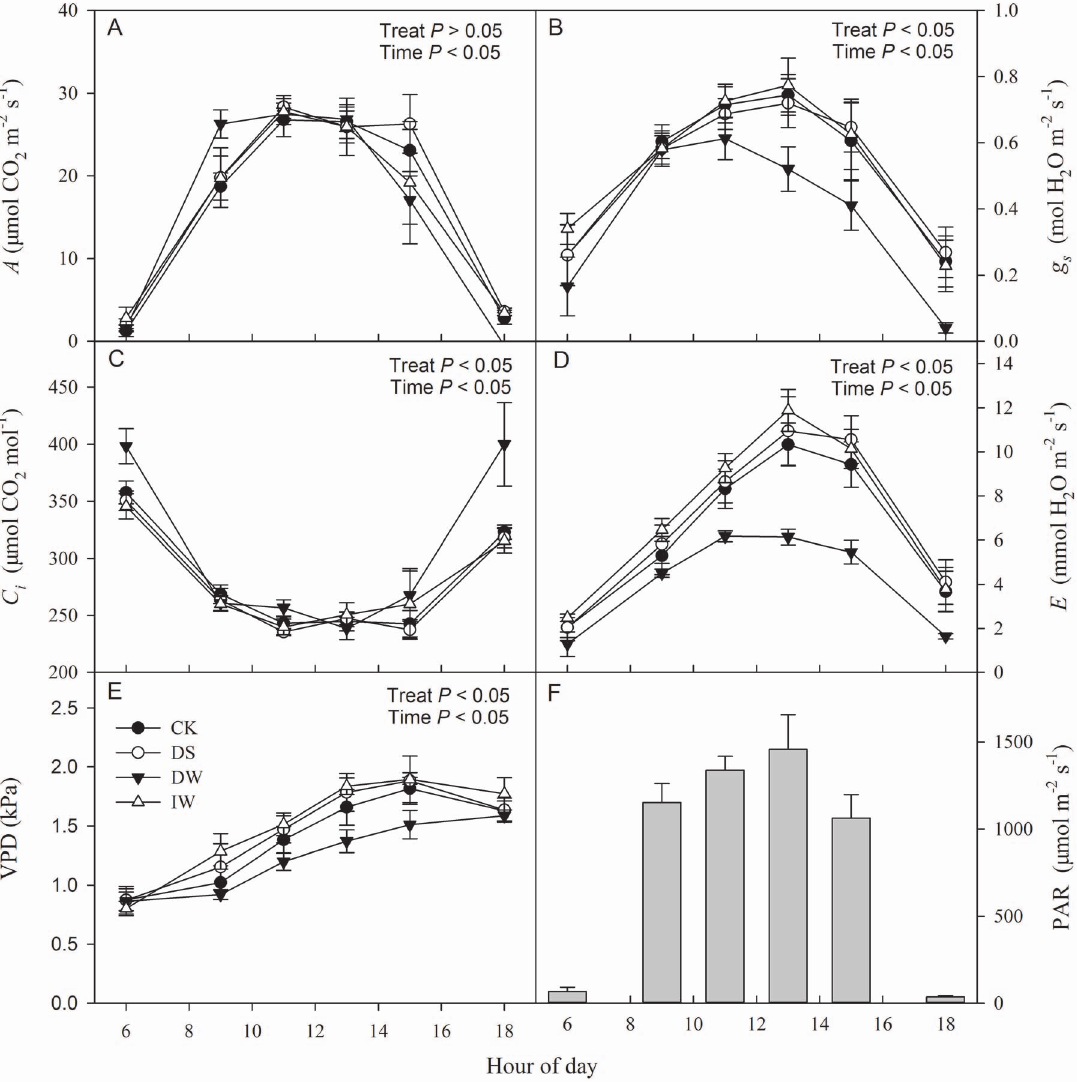
Figure 8. Diurnal changes in (A) assimilation rate ( A ), (B) stomatal conductance ( g s ), (C) intercellular CO 2 concentration ( C i ), (D) transpiration rate ( E ) and (E) atmospheric vapour pressure deficit (VPD) (mean ± SE) in winter wheat under four treatments (CK, DS, DW and IW), as well as (F) photosynthetic photon flux density (PAR) (E) in anthesis stage. P value represent the significance of the effects of each